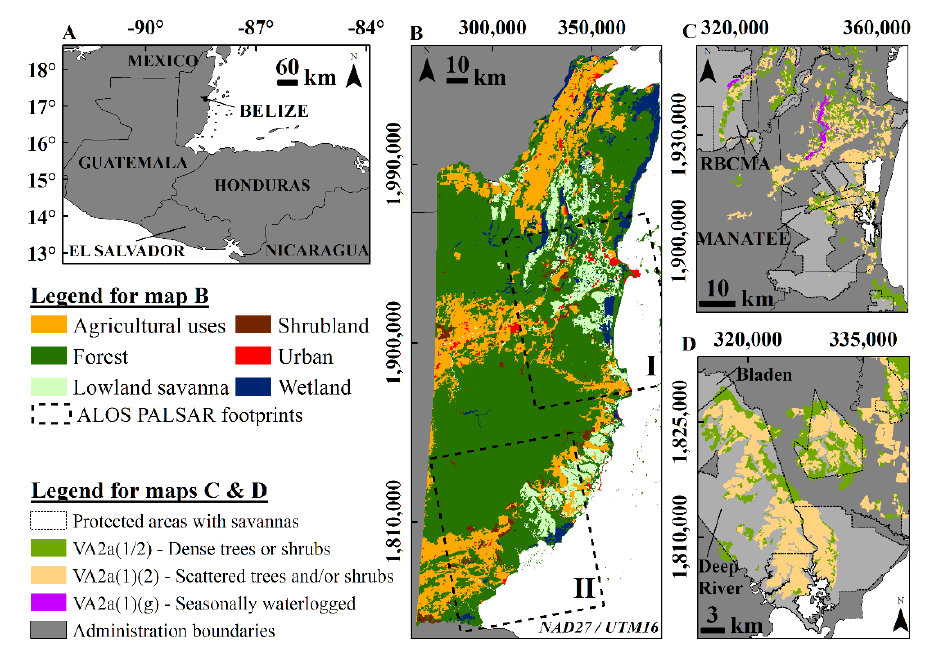
Figure 1. ( A ) Belize in the region of Central America; ( B ) footprints of the ALOS PALSAR and the national ecosystems map based on UNESCO classes; and ( C , D ) the lowland savanna areas in the ALOS PALSAR scenes; light grey areas indicate the extent of protected areas with lowland savannas; RBCMA stands for Rio Bravo Conservation and Management